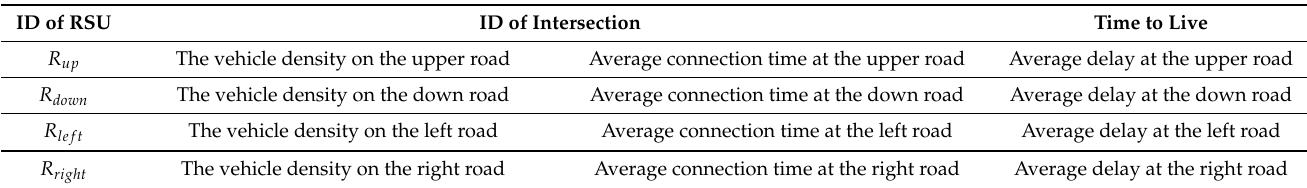
Table 4. The format of traffic information